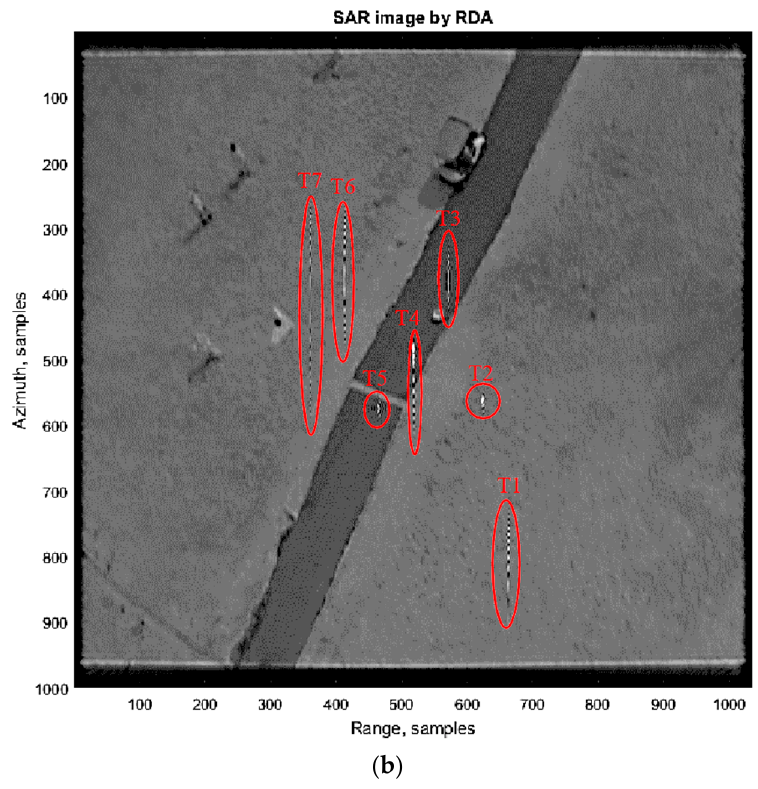
Figure 10. ( a ) The SAR raw data of the scene including moving targets and ( b ) its focused image. Table 2. Moving target parameter variations in the generated SAR images.